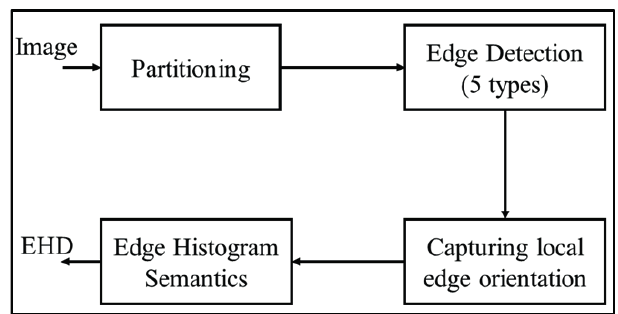
Fig. 1. Edge Histogram Descriptor process of feature